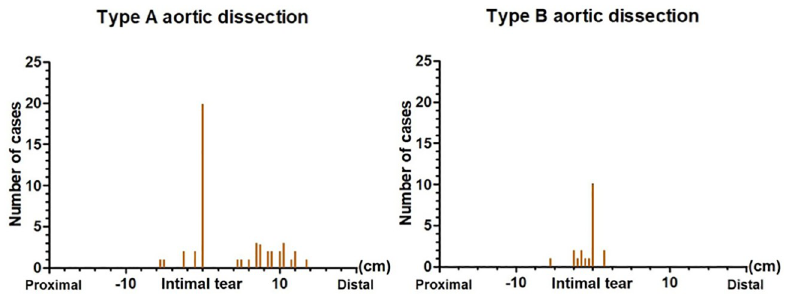
Fig 2. Distribution of aortic calcification and intimal tears in patients with acute aortic